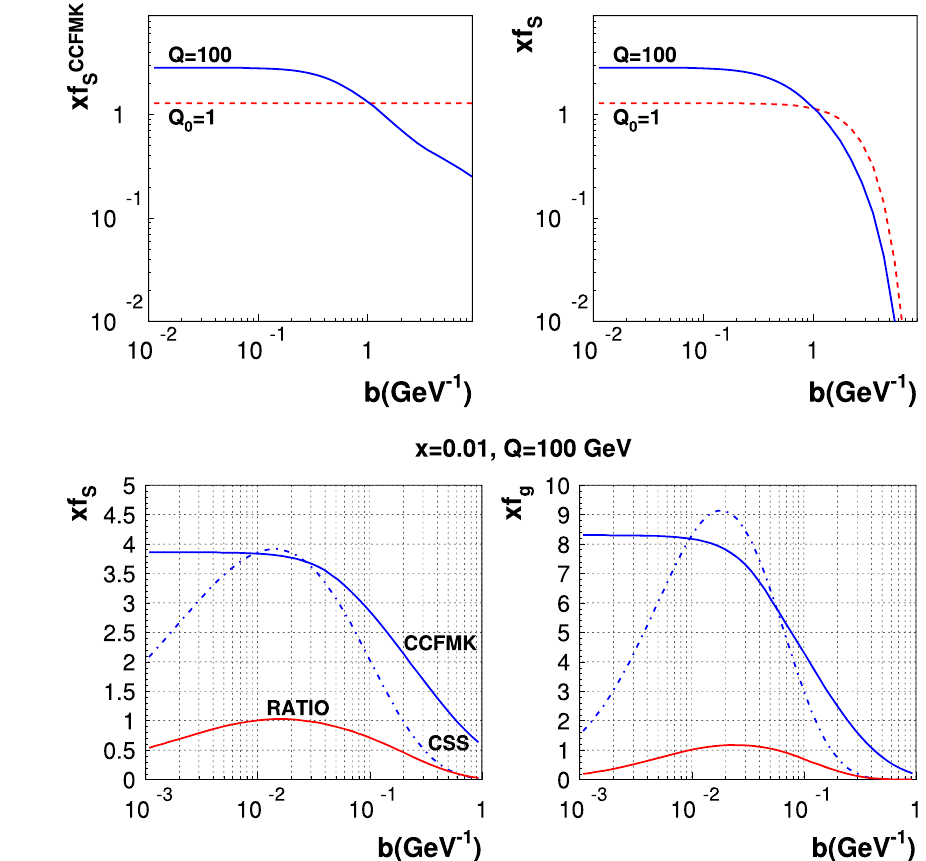
Fig. 3 The solution of Eq. (32) for singlet quark (left plot) and gluon distributions (right plot) at Q = 100 GeV and x = 10 − 2 , obtained for F ( b ) ≡ 1 (solid lines) and the CSS approximation (38) (dot-dashed lines). The ratio CSS/CCFMK curves are shown as the red solid